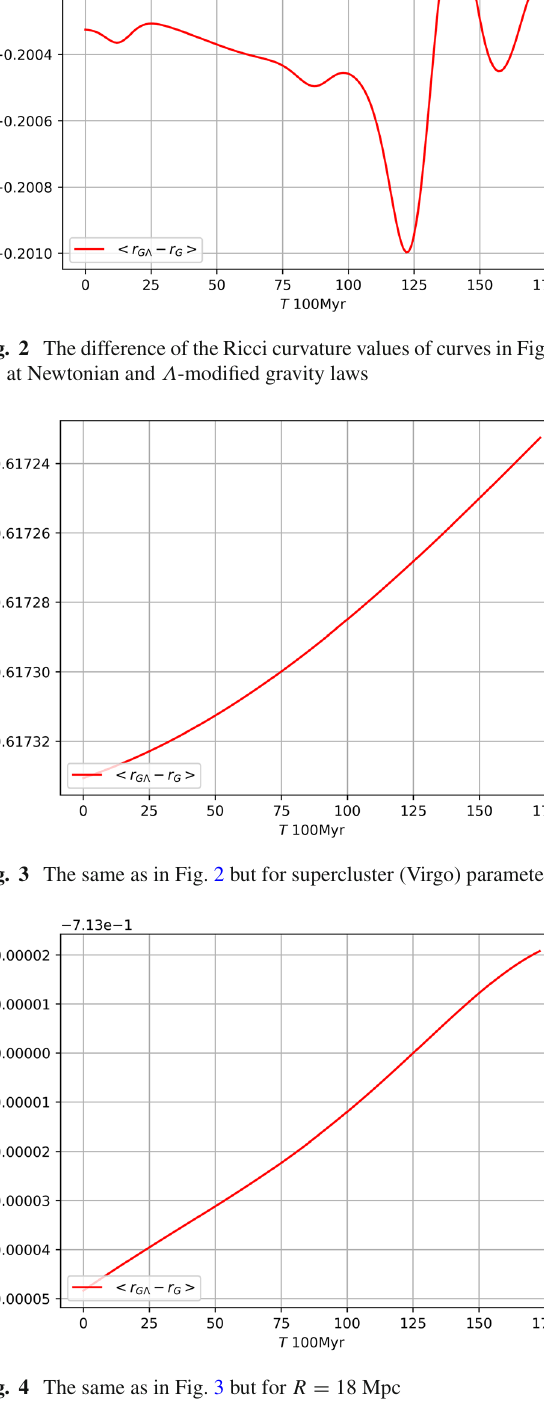
dark energy [5,6], as weak-field and cosmological manifes- tation of GR, respectively, both determined by the cosmo- logical constant.